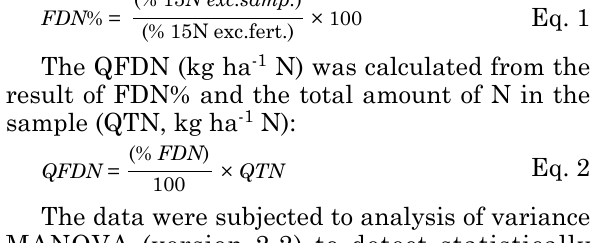
recovered from the fertilization line in Untilled (P1, P3 and P5) and tilled plots (P2, P4 and P6) distance from the fertilizer